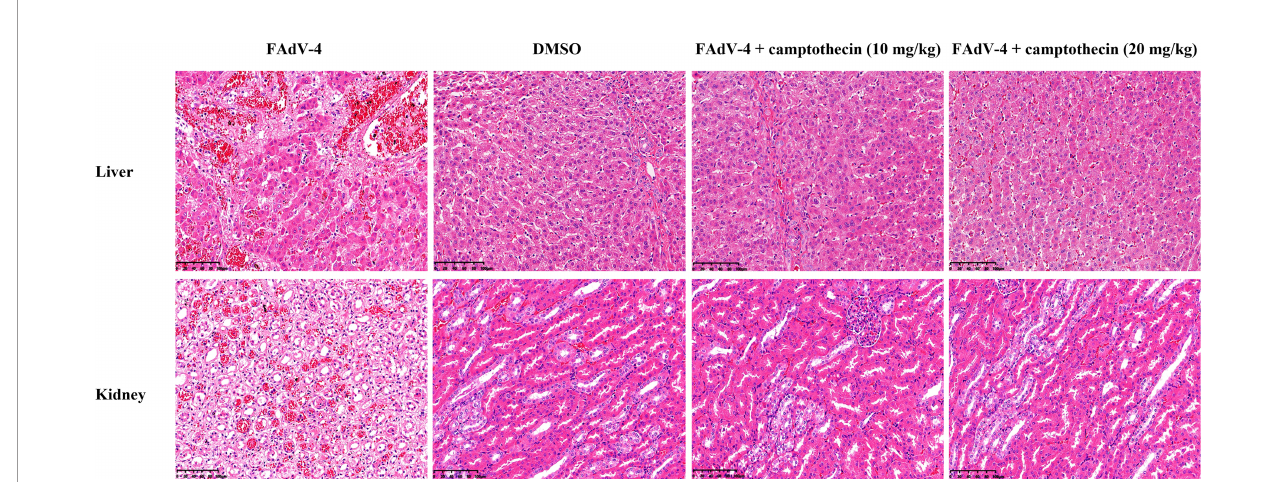
FIGURE 5 | Histopathologic lesions of the liver and kidney after camptothecin treatment in FAdV-4-infected chickens. Histopathologic changes (200×) of the liver and kidney tissues obtained from